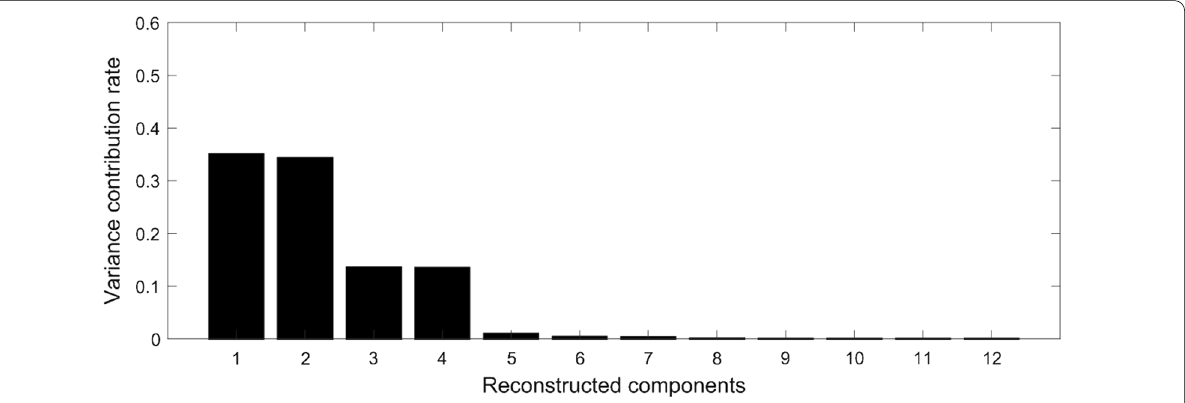
Fig. 1 Statistics of RC variance contribution rates